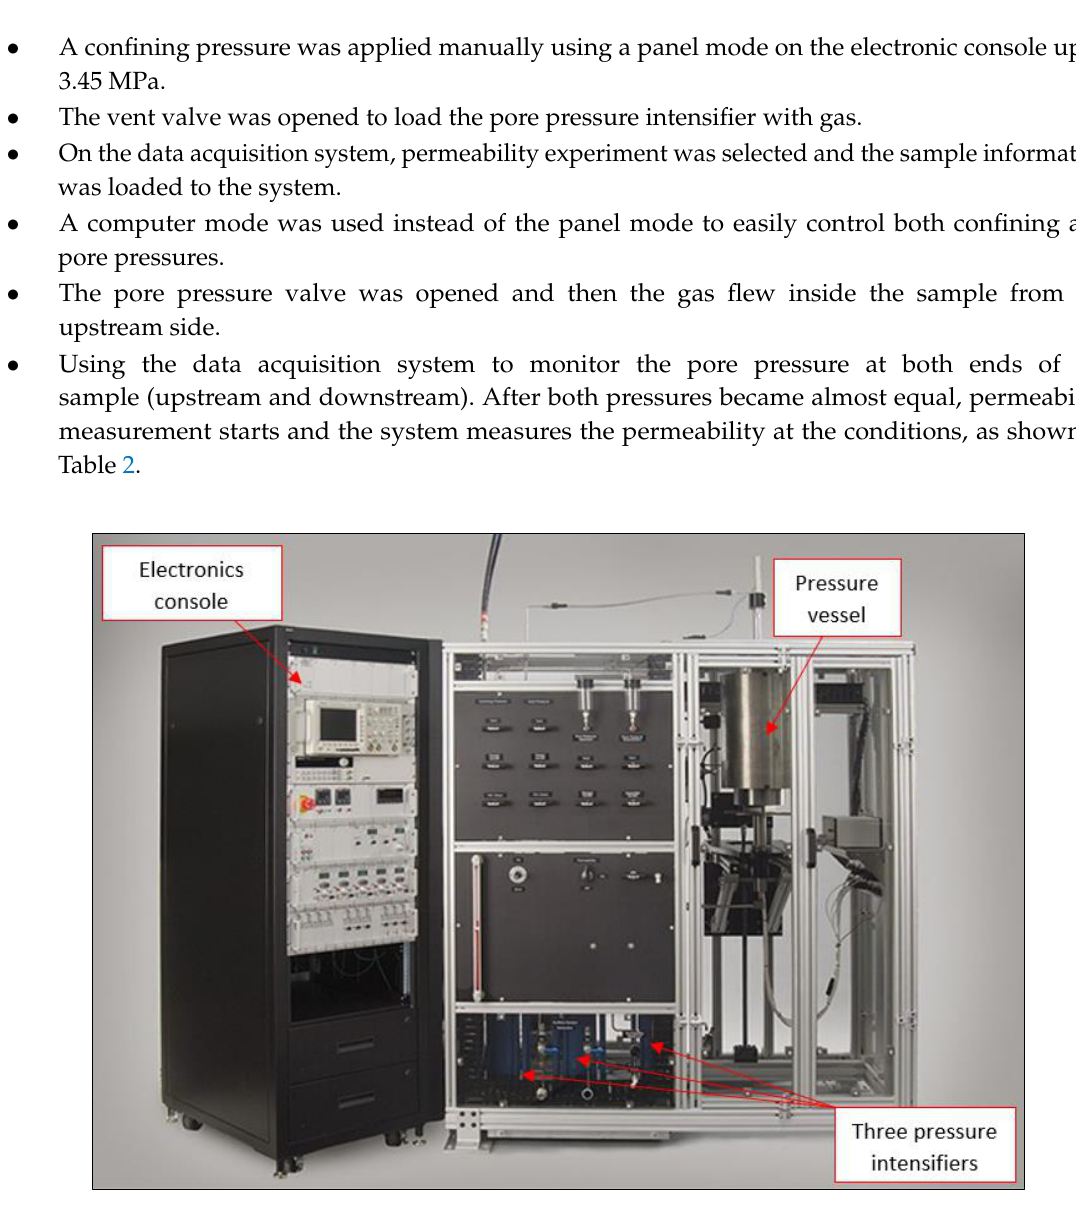
Figure 2. New Research England (NER) AutoLab 1500 system for permeability and ultrasonic velocity measurements. velocity measurements. Table 2. Parameters selected for permeability measurement. Table 2. Parameters selected for permeability